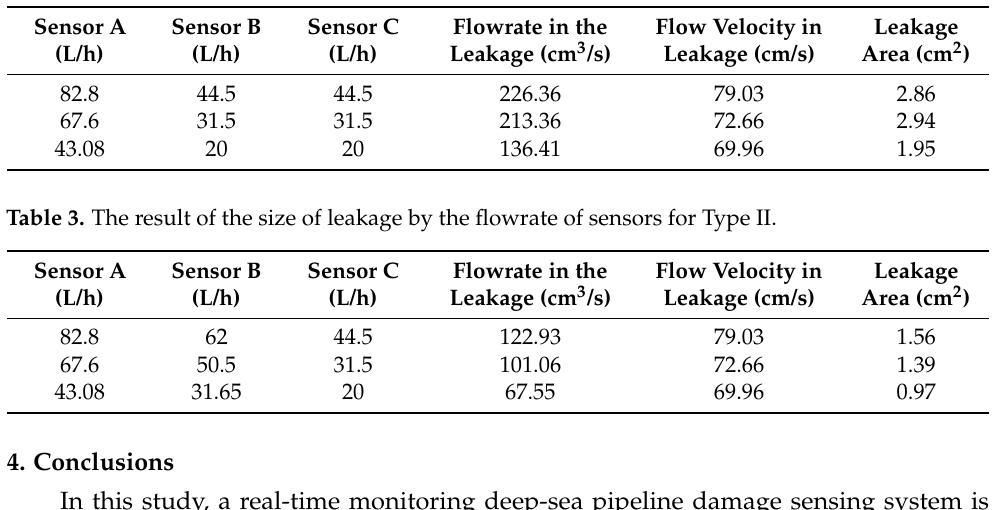
Table 2. The result of the size of leakage by the flowrate of sensors for Type I.